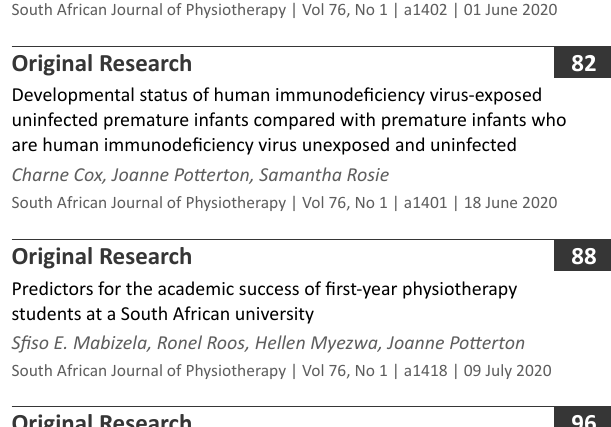
Cross-cultural adaptation and validation of the STarT back screening tool in